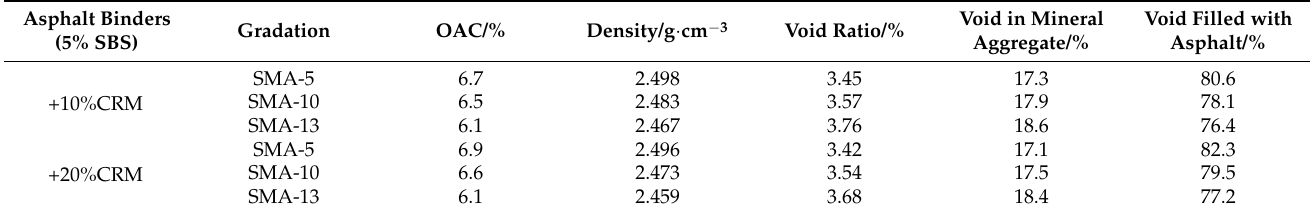
Table 8. Optimum asphalt content (OAC) of asphalt mixtures.